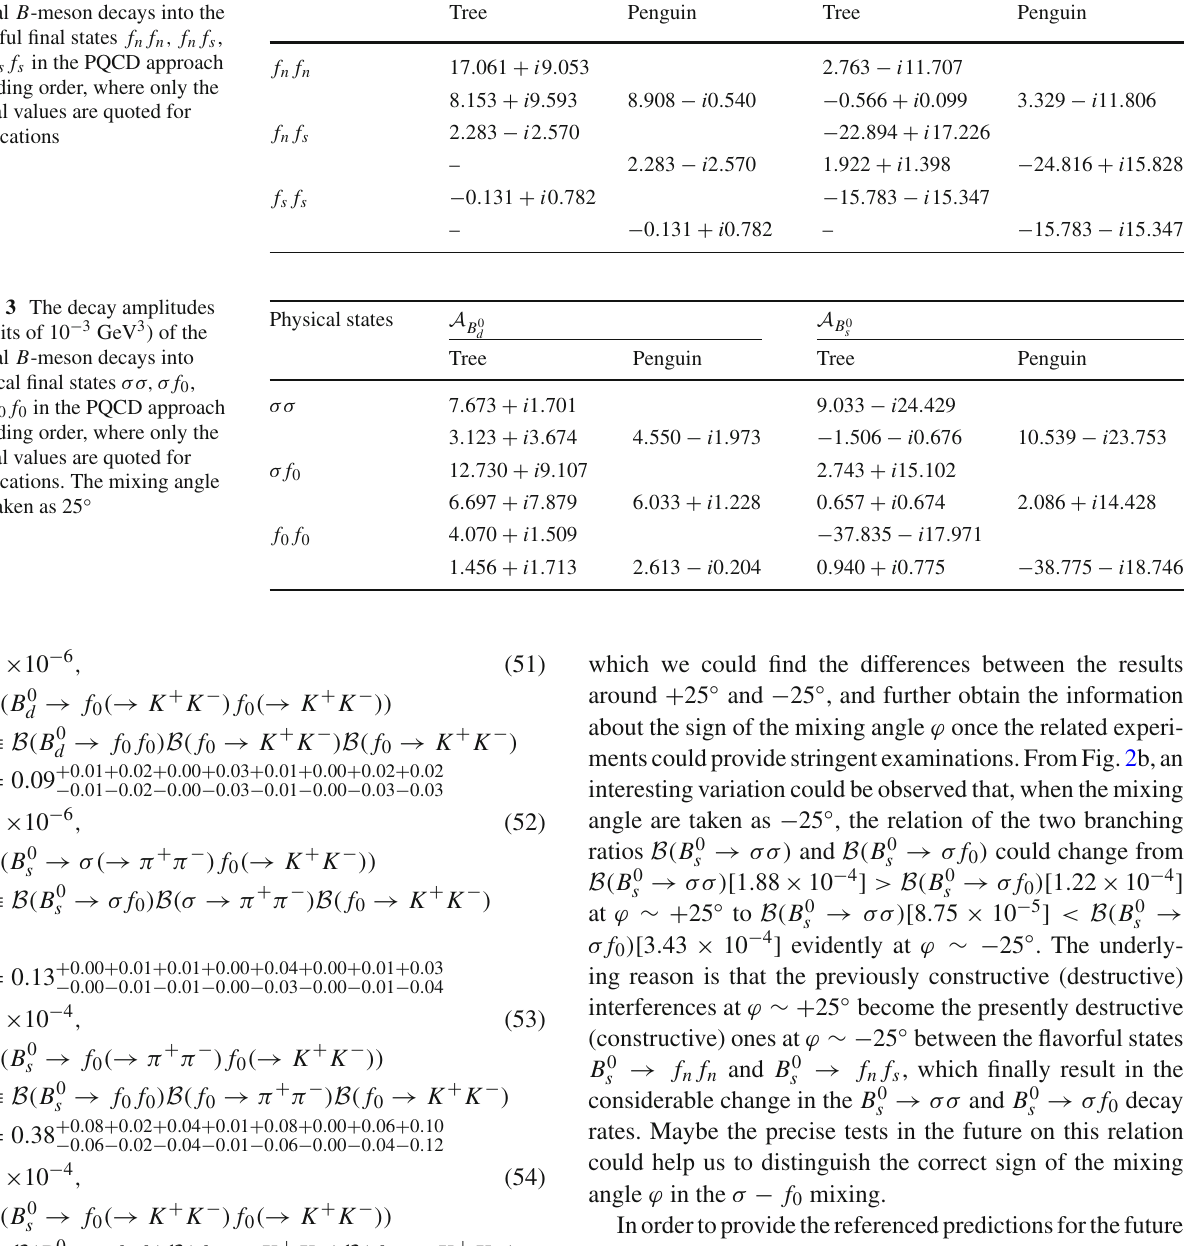
Table 2 The decay amplitudes (in units of 10 − 3 GeV 3 ) of the neutral B -meson decays into the flavorful final states f n f n , f n f s , and f s f s in the PQCD approach at leading order, where only the central values are quoted for clarifications